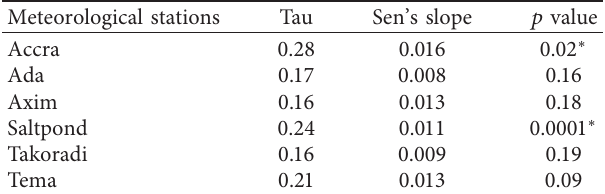
Table 3: DJF SPI Mann–Kendall test.